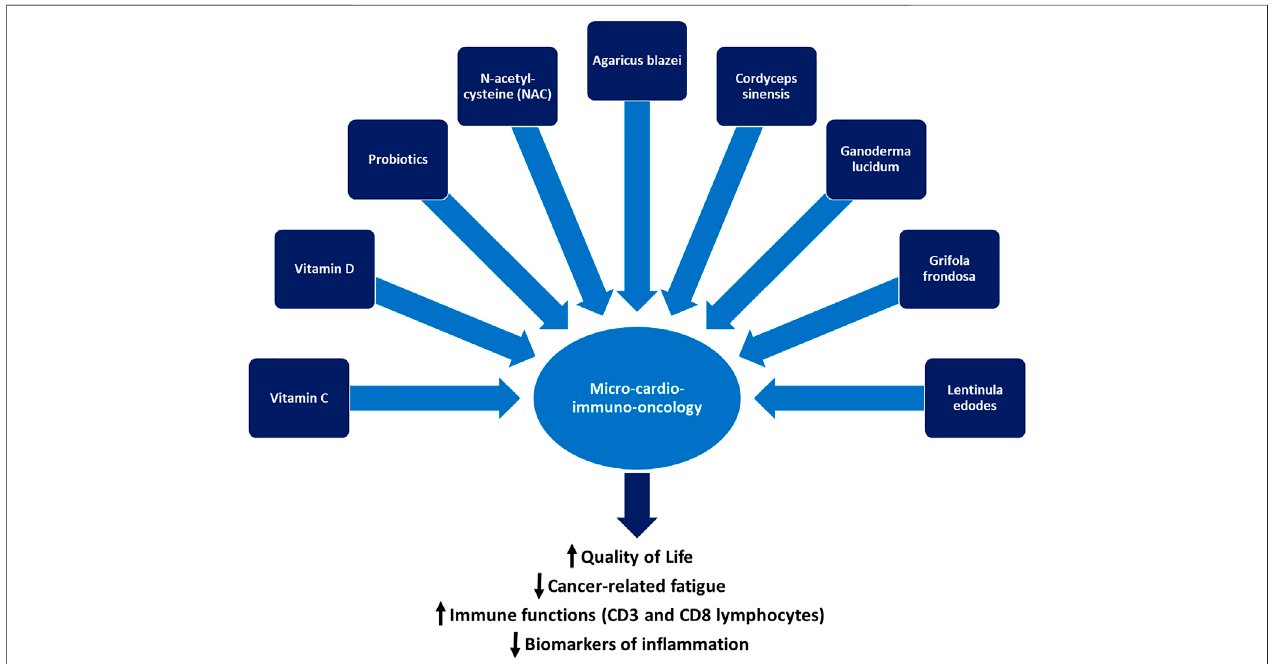
FIGURE 1 | The micro-cardio-immuno-oncology axis and the mainstays of complementary and alternative medicine: vitamin C, vitamin D, probiotics, N-acetyl- cysteine, and selected medicinal mushrooms can improve the quality of life and immune function of patients with cancer and reduce cancer-related fatigue and the systemic concentration of pro-in fl ammatory